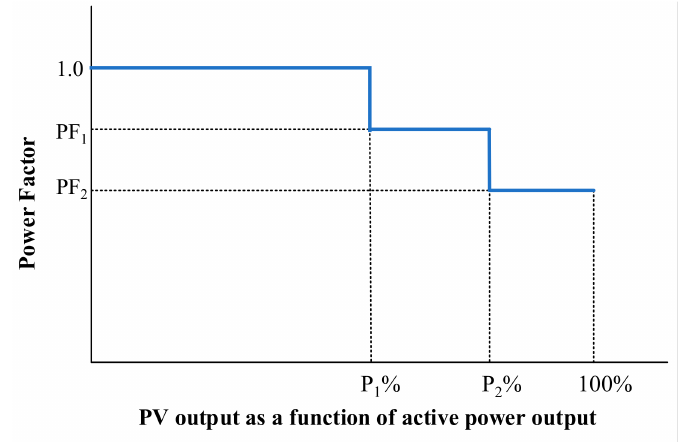
Figure 3. A generic power factor control as a function of injected active power for PV inverters.